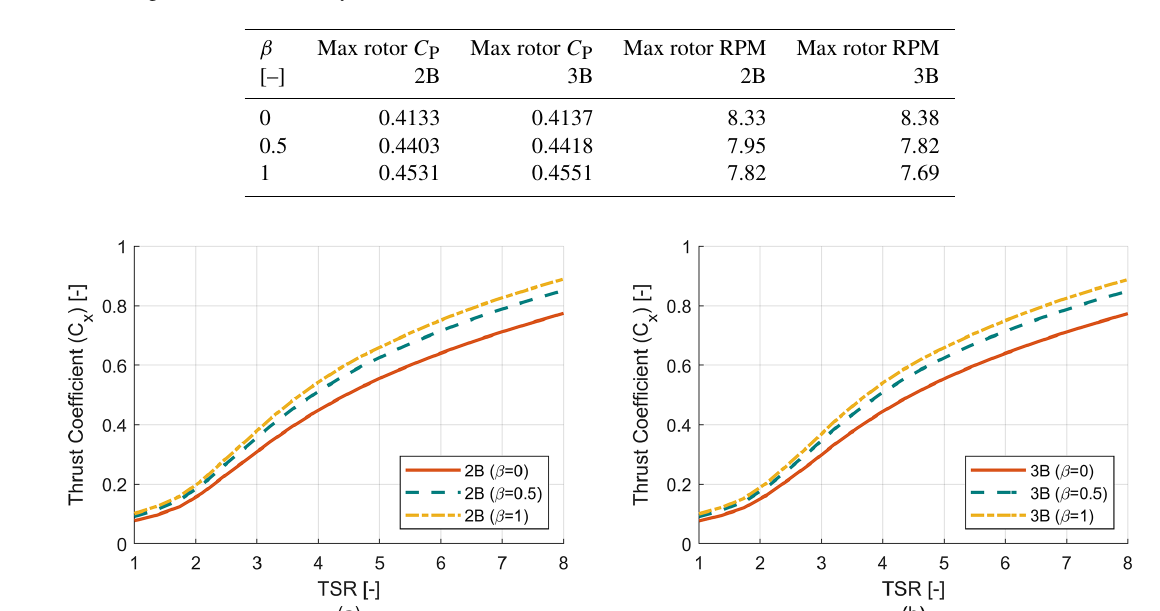
Figure 8. Rotor thrust coefficient ( C x ) analysis. (a) Thrust coefficient ( C x ) vs. TSR curve for two-bladed (2B) rotors. (b) Thrust coefficient ( C x ) vs. TSR curve for three-bladed (3B)